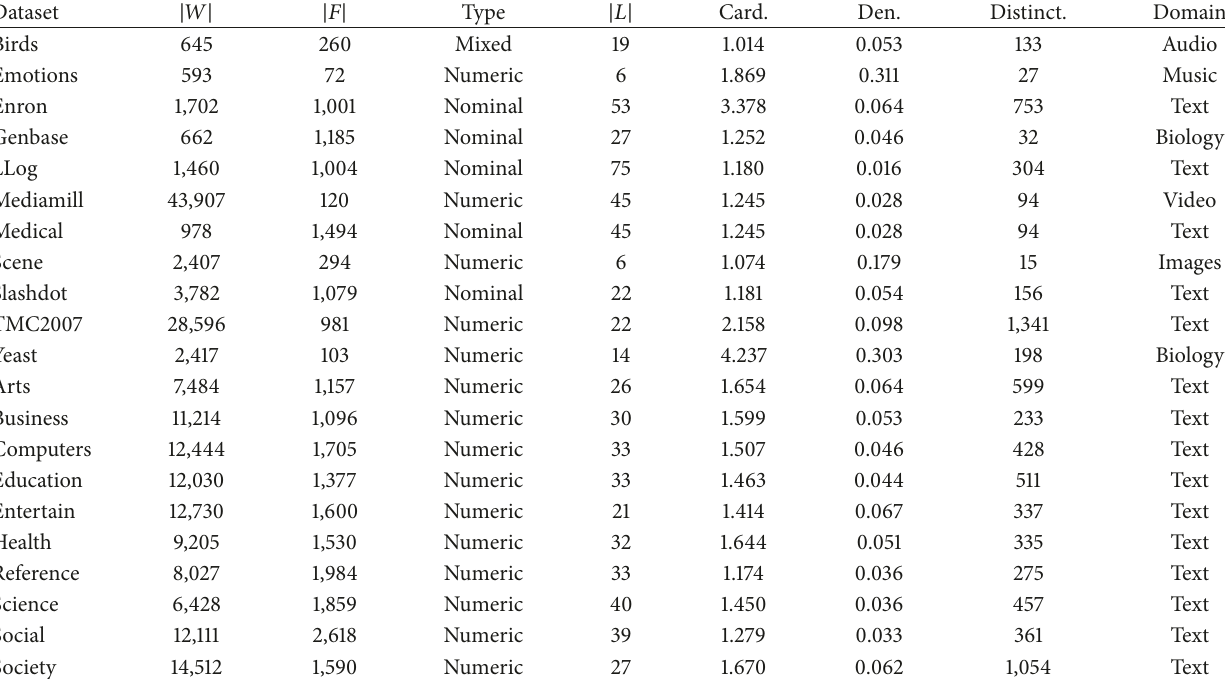
Table 1: Standard characteristics of employed